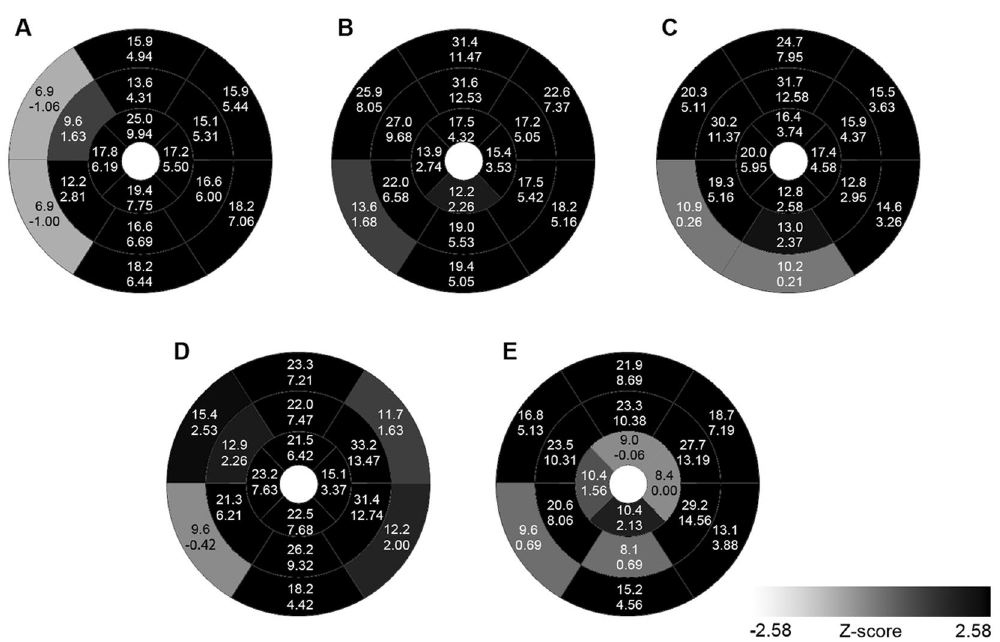
Figure 5. Distribution of left ventricular hypertrophy in patients with PRKAG2 p.V336L mutations in the current family. A, II-3; B, II-5; C, II-9; D, III-5; and E, III-6. Upper and lower values indicate absolute (mm) and standardized (z-score) end-systolic maximal wall thickness in segments. Each segment is labeled with gray scaling according to